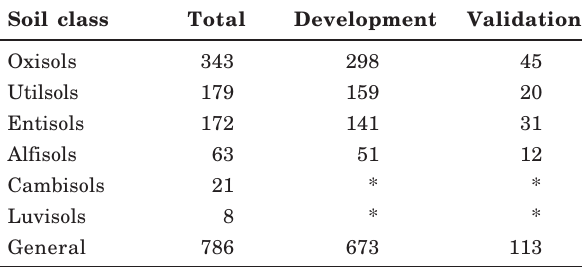
Table 1. Number of locations in the general dataset and grouped per soil class, used for PTF development (approx. 85 % of total)